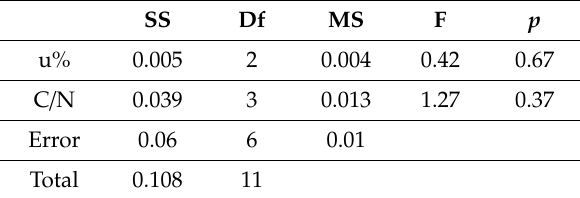
Table 9. Analysis of variance (ANOVA) for percentage of diesel oil removal. SS Df MS